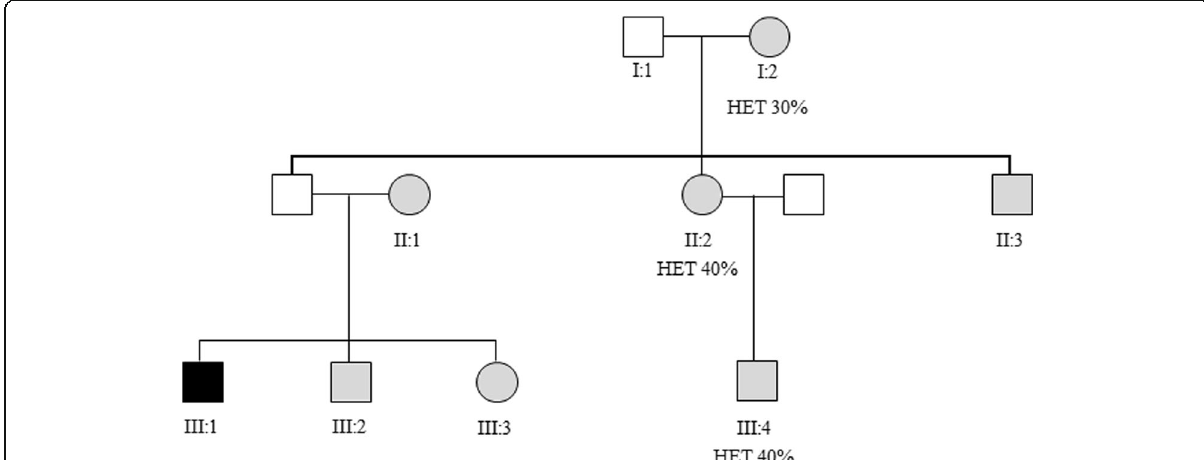
Fig. 1 Pedigree of the m.3460G > A family. The black symbol indicates the proband; gray symbols indicate asymptomatic relatives. Percentages of heteroplasmy of m.3460G > A mutation are